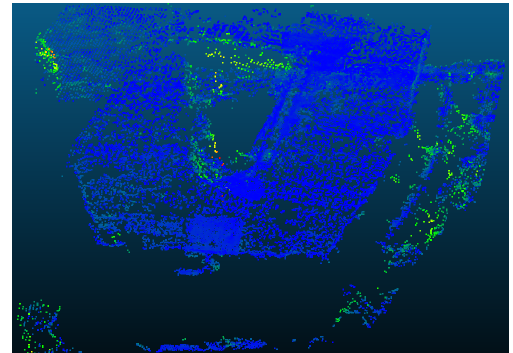
Figure 5. Distance of TIR points to the RGB point cloud after coregistration. Color from blue to red with increasing